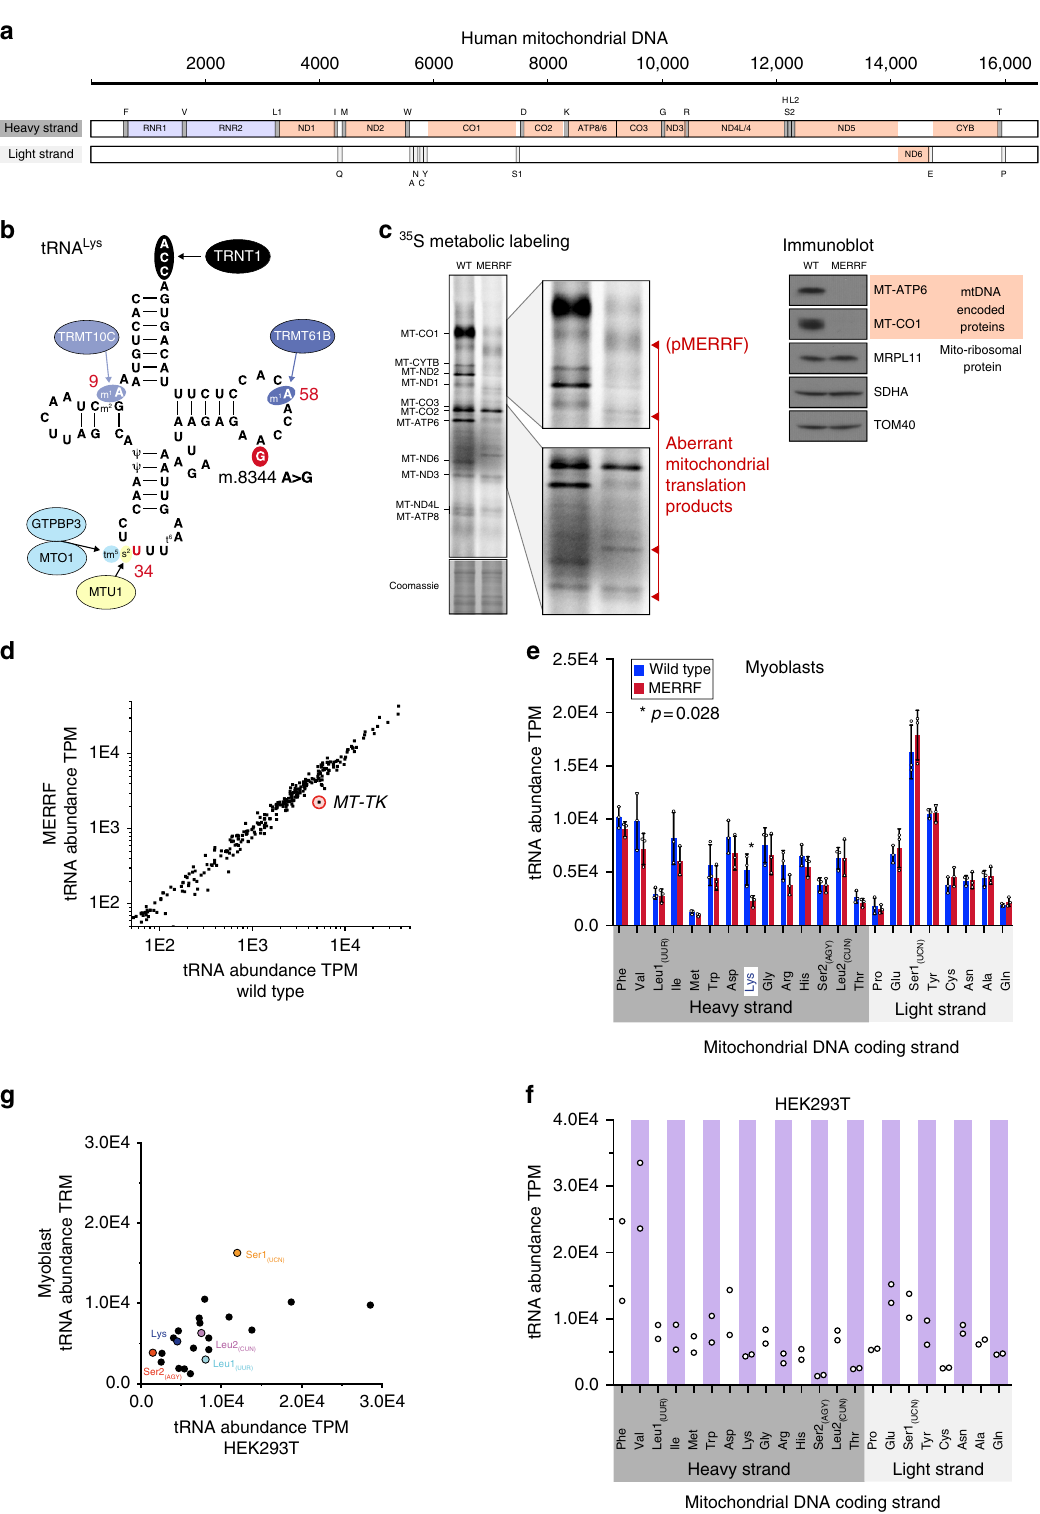
Fig. 1 Cell type-speci fi c regulation of mitochondrial tRNA stoichiometry. a Schematic of mitochondrial DNA illustrating the coding strands. b Schematic of mitochondrial tRNA Lys highlighting speci fi c RNA modi fi cations and the responsible enzymes. c Left, 35 S metabolic labeling into mitochondrial protein synthesis in human myoblasts. Right, immunoblotting of whole-cell lysates. d Uniquely aligned reads of mitochondrial tRNAs from human myoblasts from three biological replicates (Pearson ’ s coef fi cient > 0.992 for all replicate pairs). MT-TK indicates the mitochondrially encoded tRNA Lys . e Mitochondrial tRNA abundance in human myoblasts from ( c ), mean + / − S.D. ( n = 3). Paired sample t test. f Mitochondrial tRNA abundance in HEK293T cells from two independent samples. Data are from 17 . g Comparison of mean mitochondrial tRNA abundance in wild-type myoblasts vs. HEK293T cells ( r 2 =